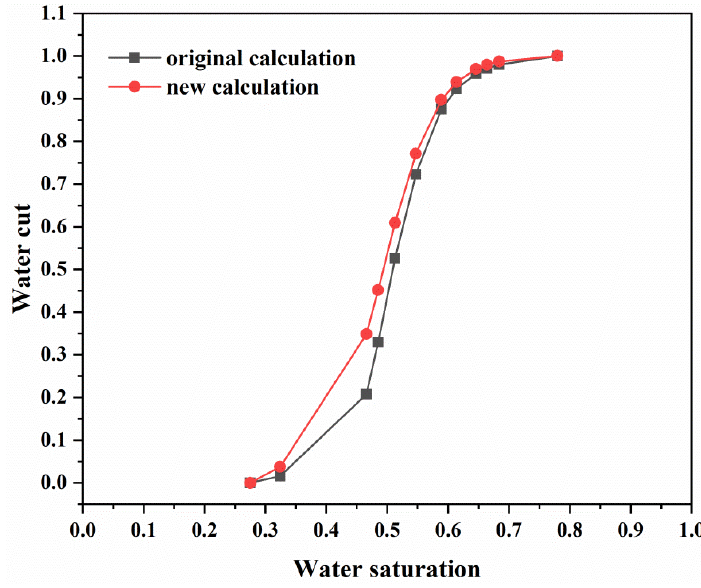
Figure 3. Comparison of water cut between two models.